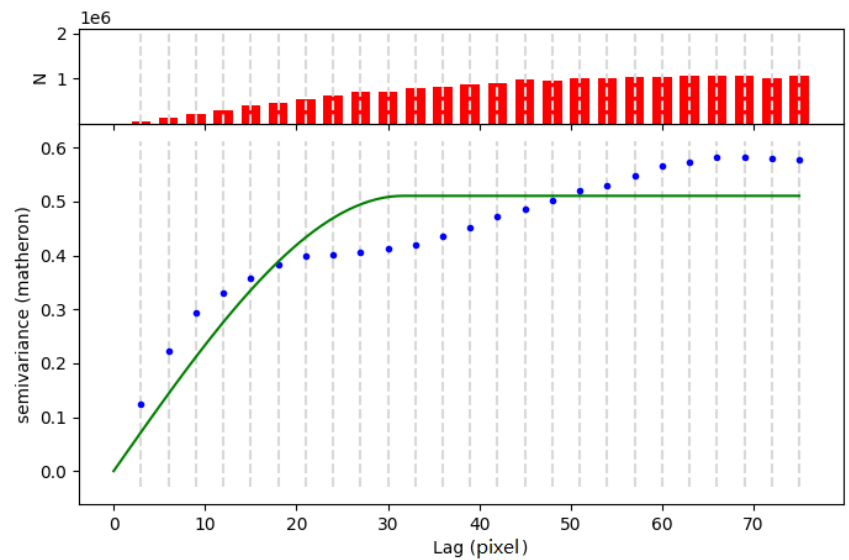
Figure 9. Semivariogram. Horizontal axis is lag distance, also known as separation distance between data points, in pixels. Blue dots represent semivariances of the corresponding lag distances in GP training dataset. Green curve is a sphere model fitted with the semivariances (blue dots). Red bins are the number of data point pairs in the same lag distance category groups.